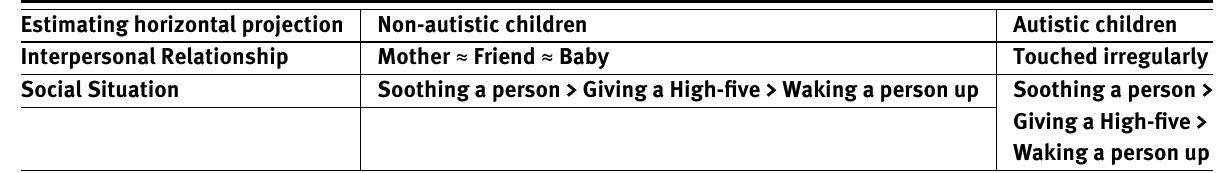
Table 3. The experimental result of estimating horizontal projection